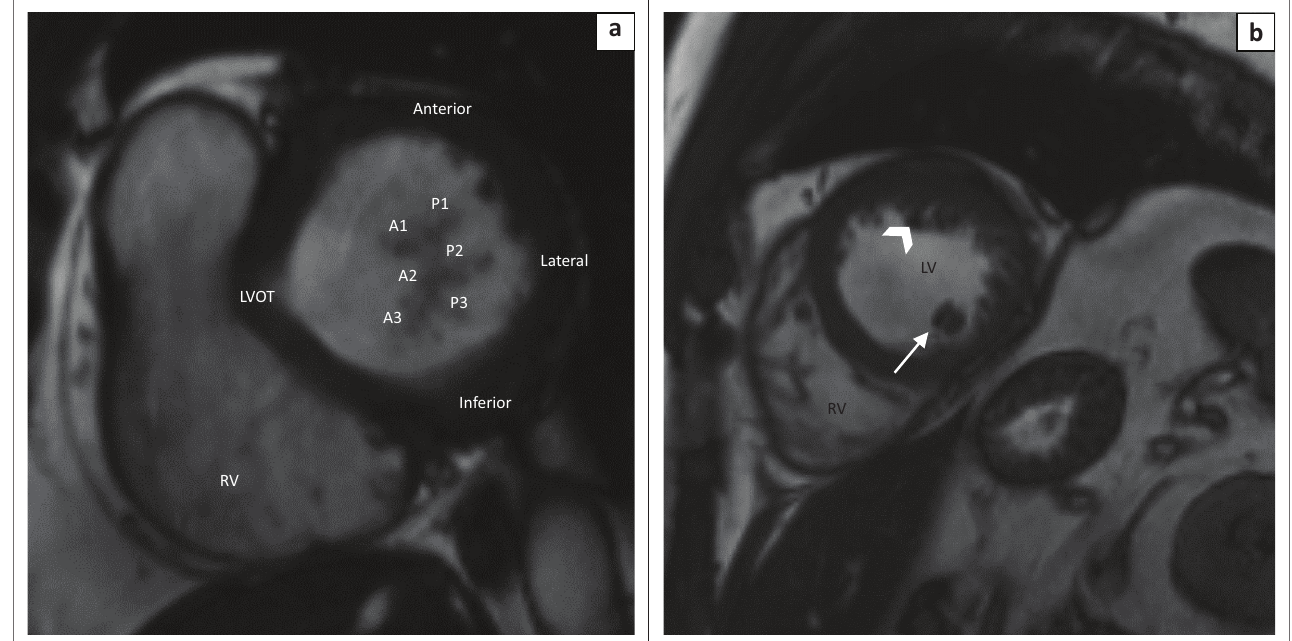
FIGURE 3: (a) Short-axis cine SSFP image demonstrates a closed mitral valve during systole, the anterior leaflet with A1, A2 and A3 portions, as well as the posterior leaflet with P1, P2 and P3 segments. (b) Short-axis cine SSFP image demonstrates the anterior lateral (arrowhead) and inferior medial (white arrow) papillary muscles of the mitral valve.